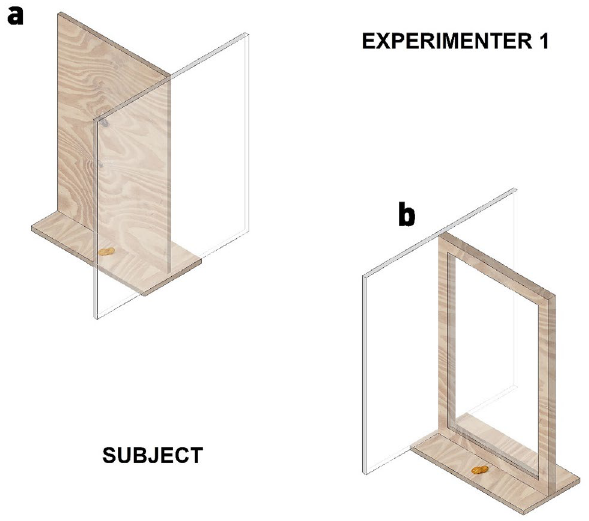
Figure 3. Apparatus used in Experiment 3: ( a ) opaque barrier, ( b ) transparent